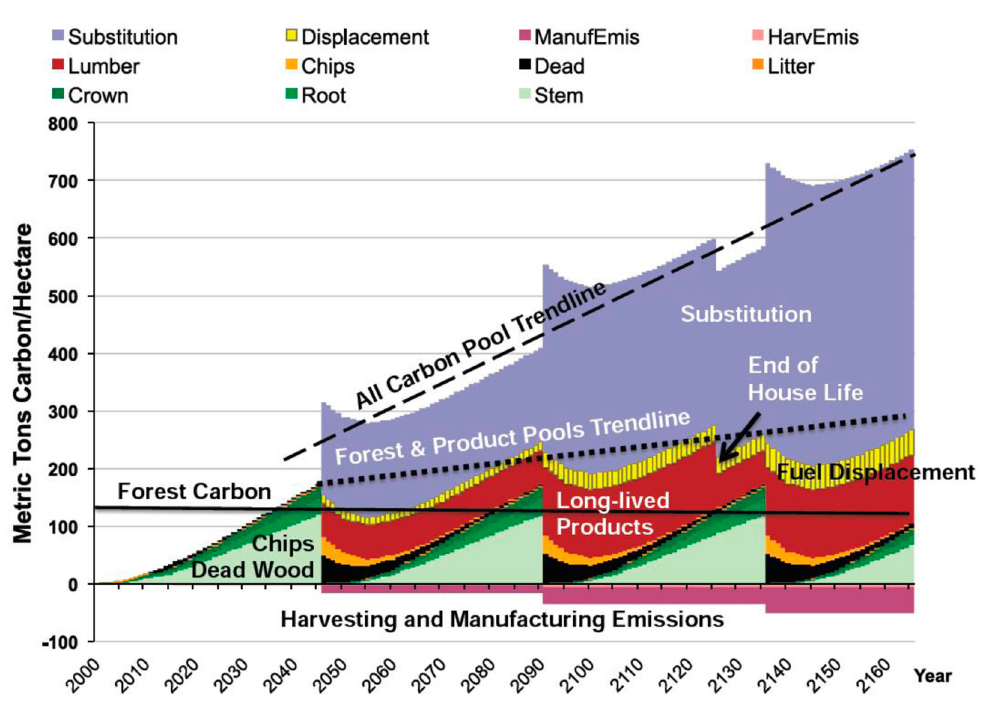
Figure 2. Carbon pools in forest stand, forest products, and under forest product substitution. From west by Perez-Garcia et al. [86] and Lippke et al.